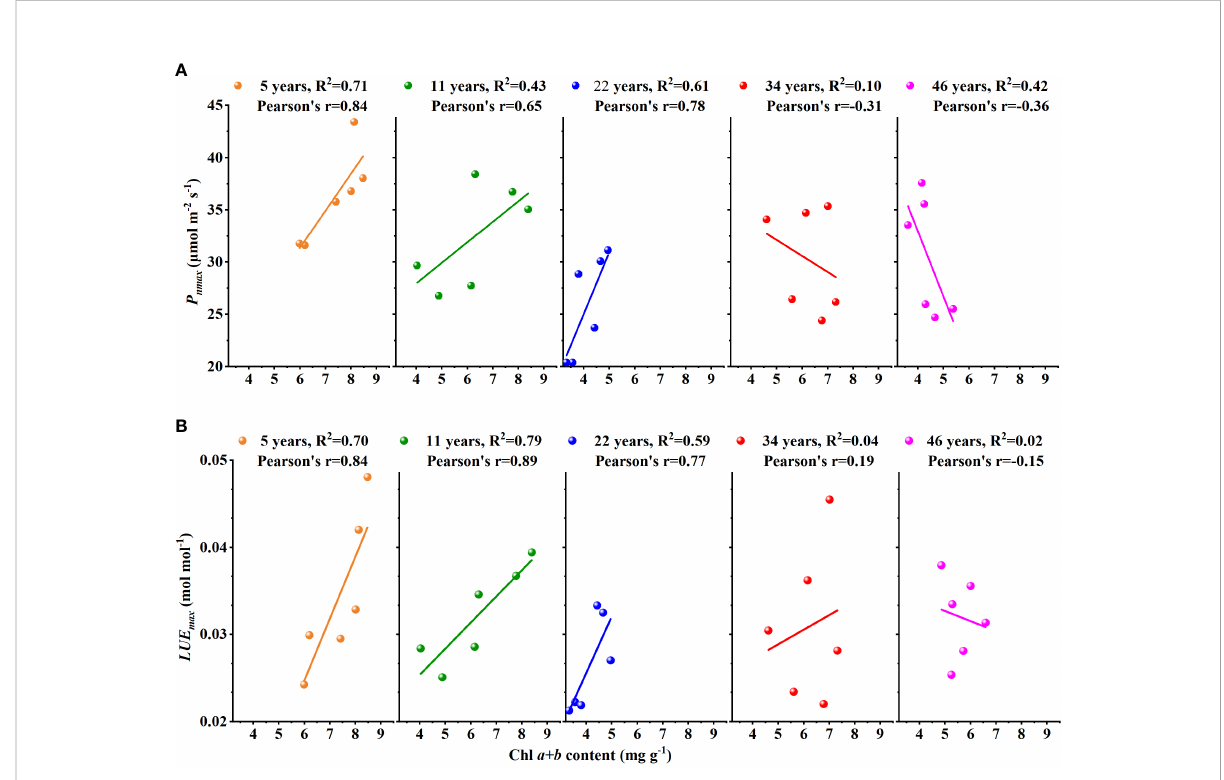
FIGURE 6 The relationships (A) between Chl a+b content and P nmax and (B) between Chl a+b content and LUE max changes with the stand age of Haloxylon ammodendron